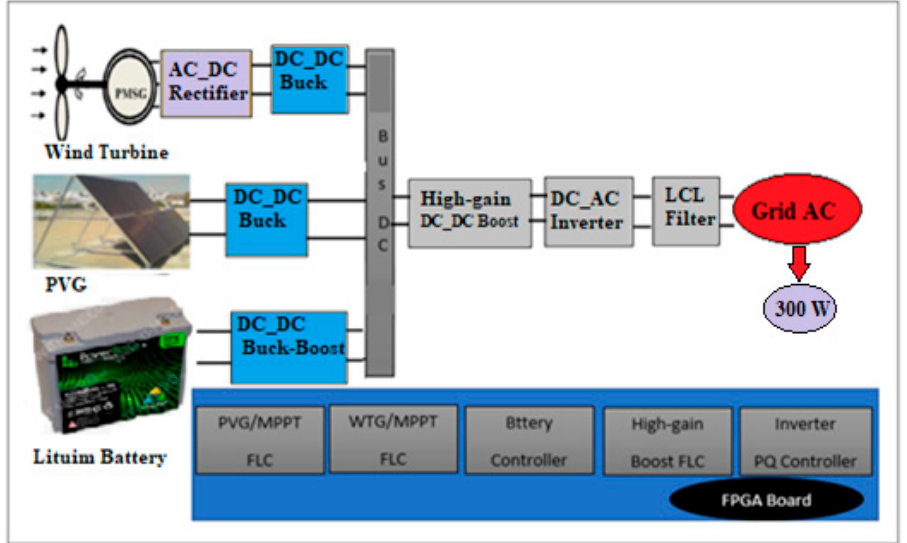
Figure 1. Scheme of the hybrid system.